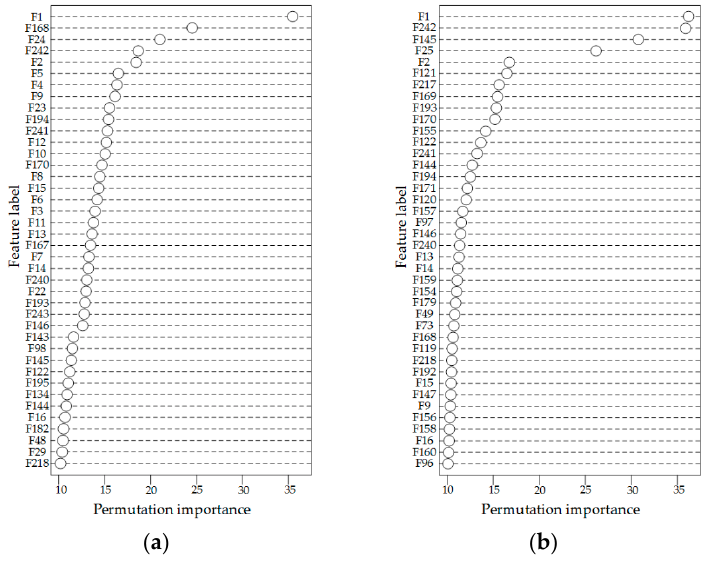
Figure 5. ( a ) The permutation importance (PI) values of the first 40 features of 1 ‐ h ‐ ahead prediction; ( b ) The permutation importance (PI) values of the first 40 features of day ‐ ahead prediction.